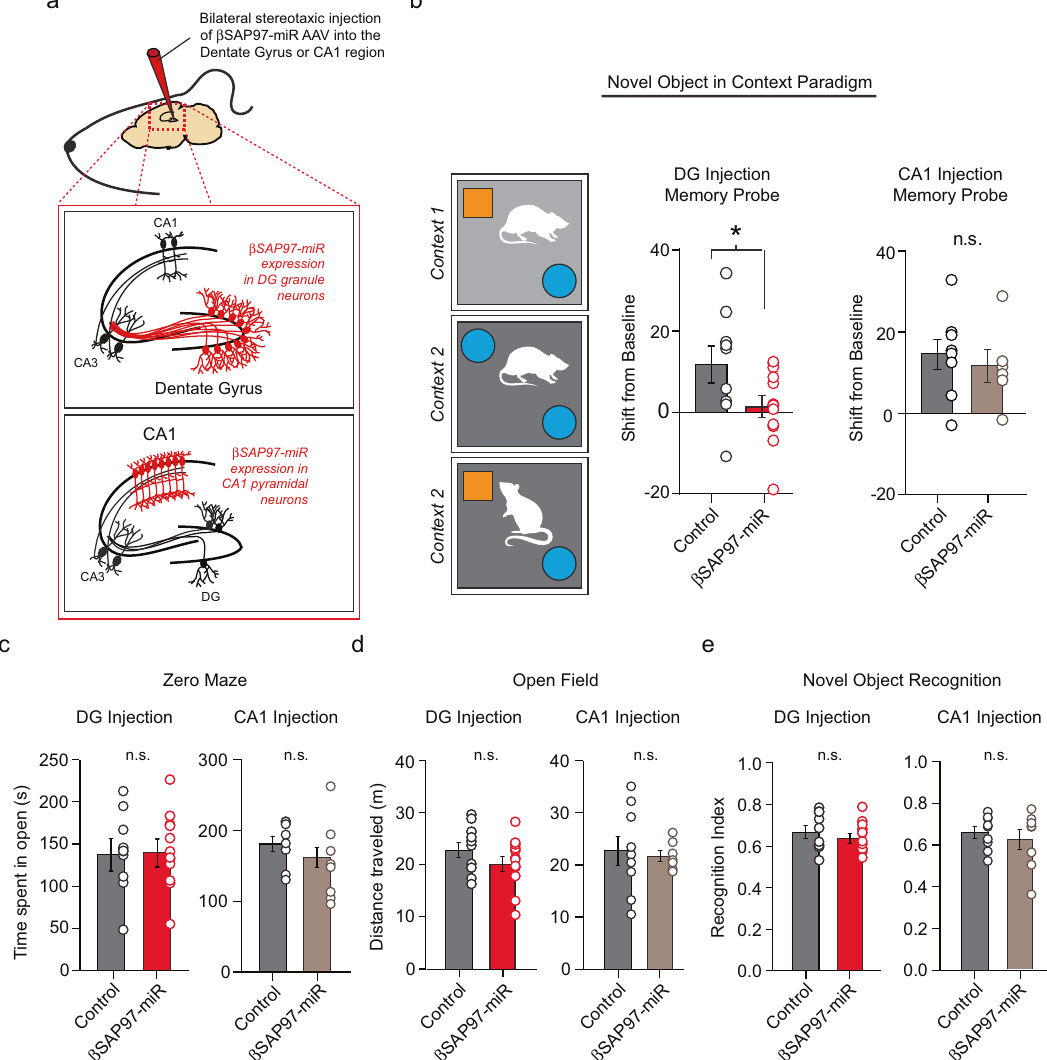
Fig. 4 Knockdown of β SAP97 expression in the dentate gyrus disrupts contextual episodic memory. a Illustration of method used to inhibit β SAP97 function within the dentate gyrus or the CA1 region of the hippocampus. b (Left) Experimental setup of the Novel Object in Context behavioral procedure. (Center) Compared to control animals, β SAP97-miR expression in the dentate gyrus led to a signi fi cantly reduced exploration of the object that was novel in Context 2, expressed as a shift from baseline exploration for the same object in Context 1 (control n = 9, β SAP97 KD n = 12, p = 0.04, ANOVA). (Right) β SAP97-miR expression in the CA1 region led to no signi fi cant changes in exploration of the object that was novel in Context 2 (control n = 8, β SAP97 KD n = 6, p = 0.61, ANOVA). c Control and β SAP97 knockdown animals spent similar amounts of time in the open zones in a Zero Maze test for anxiety-like behavior following β SAP97-miR AAV injections in either the dentate gyrus (Left, control n = 10, β SAP97 KD n = 12, p = 0.91, two sample T test) or the CA1 region (Right, control n = 8, β SAP97 KD n = 8, p = 0.3, two sample T test). d Control and β SAP97 knockdown animals traveled similar distances in an Open Field test for exploratory behavior and general activity following β SAP97-miR AAV injections in either the dentate gyrus (Left, control n = 10, β SAP97 KD n = 12, p = 0.2, two sample T test) or the CA1 region (Right, control n = 9, β SAP97 KD n = 7, p = 0.76, two sample T test). e Recognition indices of control and β SAP97 knockdown animals were similar during a Novel Object Recognition task following β SAP97-miR AAV injections in either the dentate gyrus (Left, control n = 9, β SAP97 KD n = 12, p = 0.43, ANOVA) or the CA1 region (Right, control n = 9, β SAP97 KD n = 8, p = 0.54, ANOVA). * p < 0.05; n.s., not signi fi cant. All statistical tests performed were two-tailed. Source data are provided in the Source Data fi